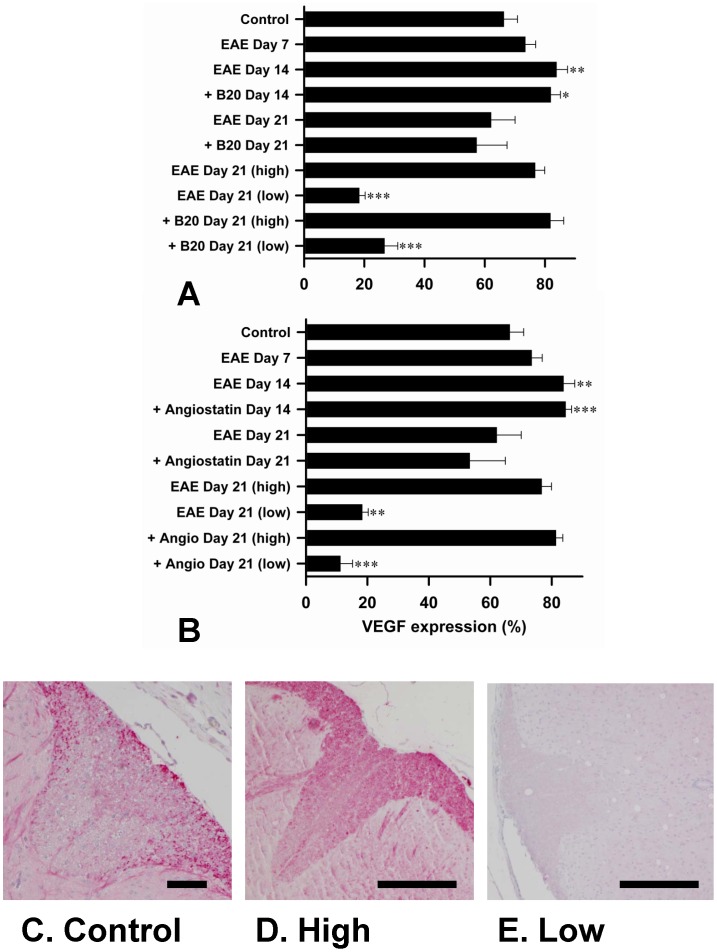
Treatment With B20.4.1.1 or K(1-3) has no Effect on VEGF Expression During EAE.A,B. Bar charts show per mouse data on VEGF expression, using the % area of positive staining in the dorsal columns. Control mice were disease-free. EAE alone is compared to mice treated during EAE with B20-4.1.1 (A) or K(1-3) (B). Day 21 data is further subdivided into high and low expression (n = 6 mice in EAE alone, n = 5 at day 21, high expression group n = 3/5, low n = 2/5; n = 9 mice for B20-4.1.1 treated mice, n = 5/9 for high expression group, low n = 4/9; n = 10 mice for K(1-3) treated mice, n = 6/10 for high expression group, low n = 4/10; data is mean ± SEM, significance relative to untreated controls, *–***, P<0.05–0.001). C–E. Representative images of dorsal column expression of VEGF for untreated controls (C), high expression B20.4.1.1 treated EAE day 21 (D) and low expression K(1-3) treated EAE day 21 (E). Scale bar = 100 µm.